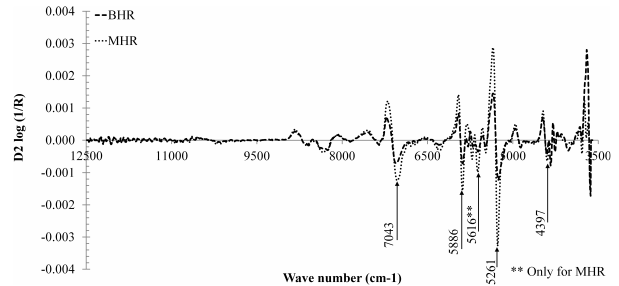
Fig. 3. Average second-derivative of NIR spectra of BHR, MHR obtained using an FT-NIR spectrometer over the wave number region 12,500 – 4,000 cm (cid:1) 1 .